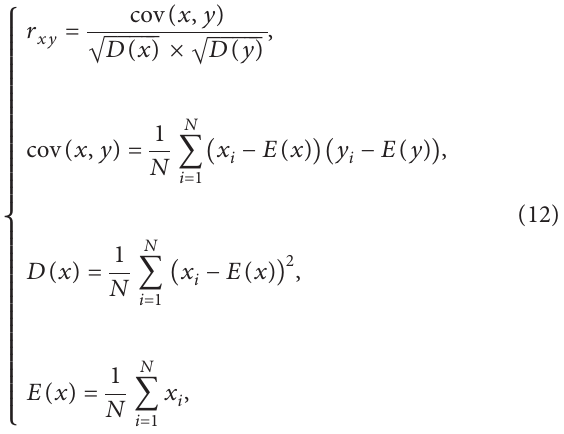
Figure 8: Key sensitivity analysis. (a) Plain image, (b) correctly encrypted image ( E E 1 and E 2 , (e) incorrectly decrypted image, and (f) correctly decrypted